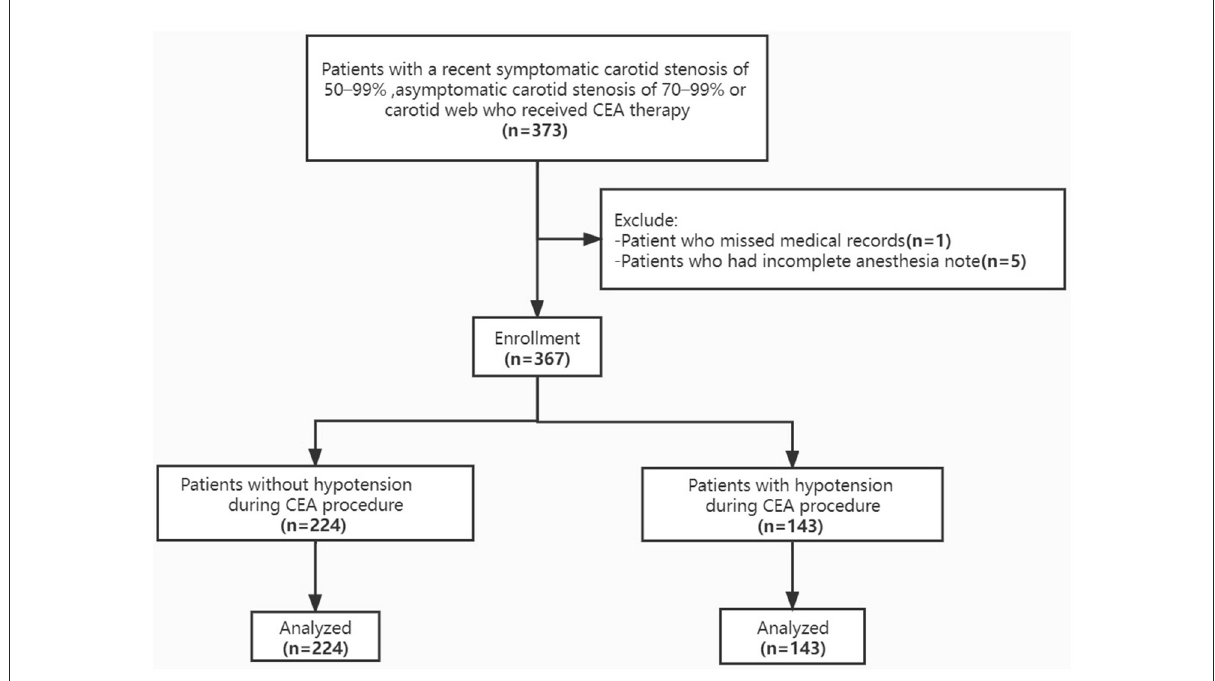
FIGURE1 Flow diagram of the study